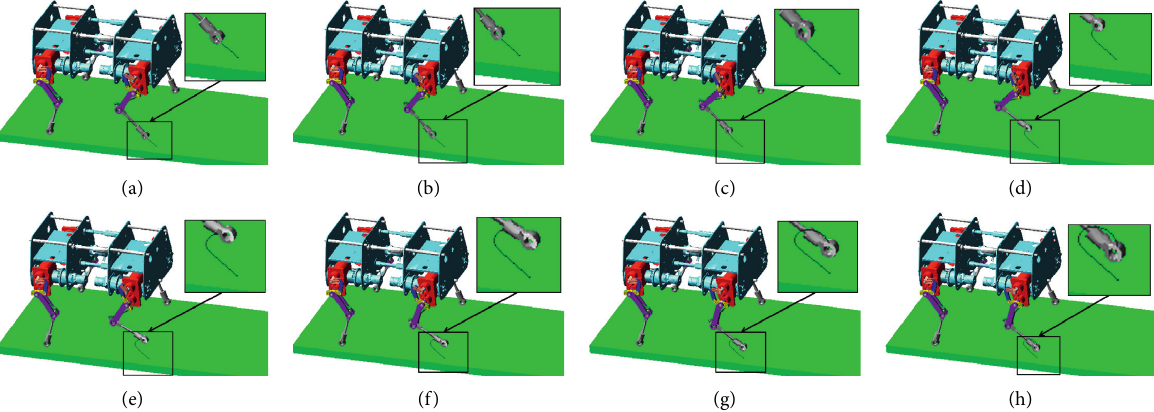
Figure 15: Virtual prototype motion process using the point distributions obtained by PSO algorithm. (a) Start. (b) 1/7 period. (c) 2/7 period. (d) 3/7 period. (e) 4/7 period. (f) 5/7 period. (g) 6/7 period. (h) 1 period.